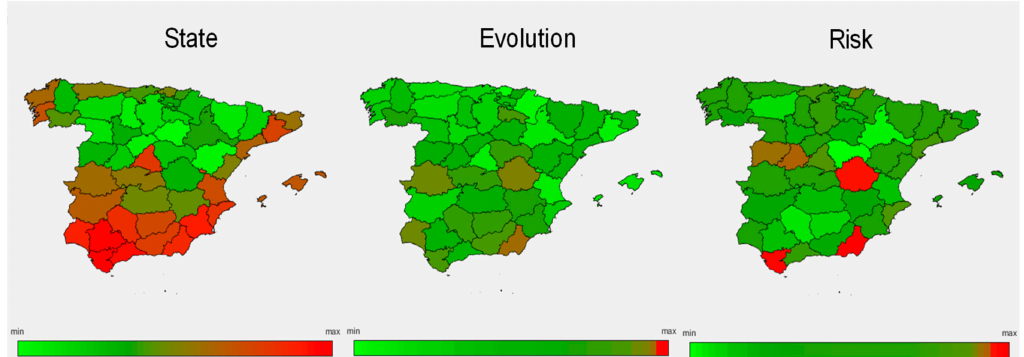
Figure 5. Results by province of the urban vulnerability assessment process: UV State in 2011, evolution of UV state between 2001 and 2011, and risk of increasing UV from 2011 onwards.